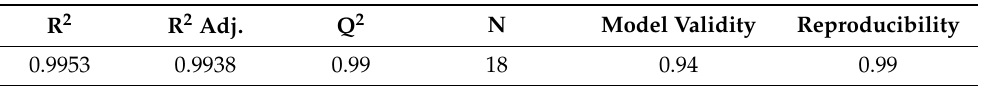
Table 3. Summary of fit for the applied model. R 2 : measure of fit, Q 2 : estimation of precision for the prediction, N: number of